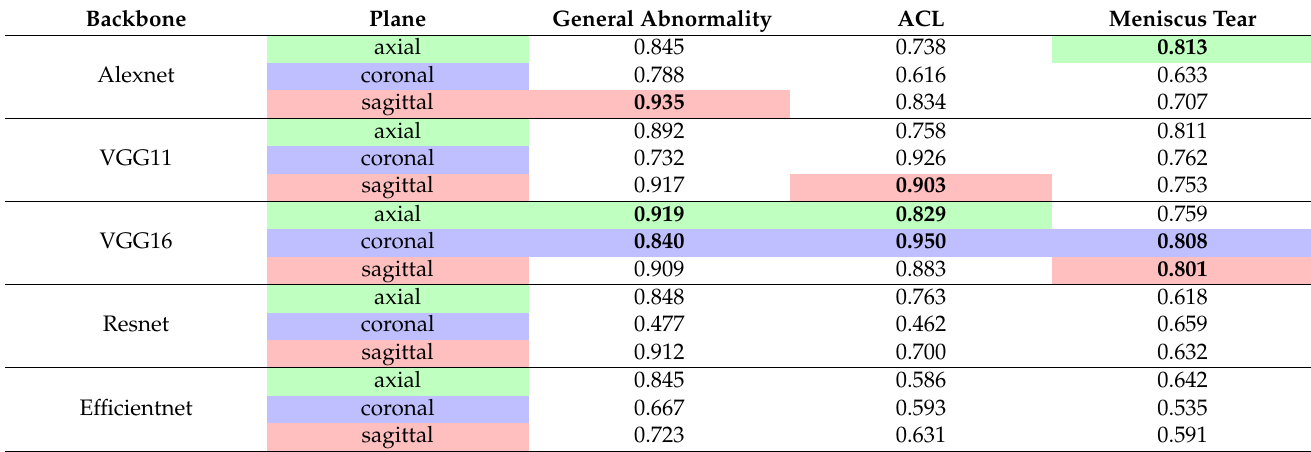
Figure 7. Cohen’s Kappa scores per model and for each diagnosis type: ( a ) general abnormality classification, ( b ) ACL tear classification, ( c ) meniscus tear classification. Table 4. ROC-AUC evaluation of each backbone per MRI plane. Highest evaluation scores per plane and for given diagnosis are highlighted with respective plane